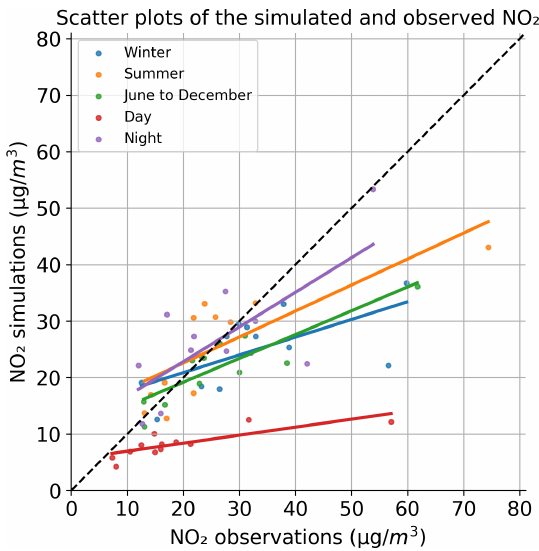
Figure 4. Scatter plot of the simulated and observed NO 2 concen- trations for the 14 stations used for the validation at the different periods. Winter is the December month (blue line), summer is July (orange line), June to December includes measurements for the whole period of study (green line), day represents the daily hours (between 12:00 and 15:00 local time) during the whole period (red line) and night represents the night hours (between 00:00 and 03:00 local time) during the whole period (purple line).